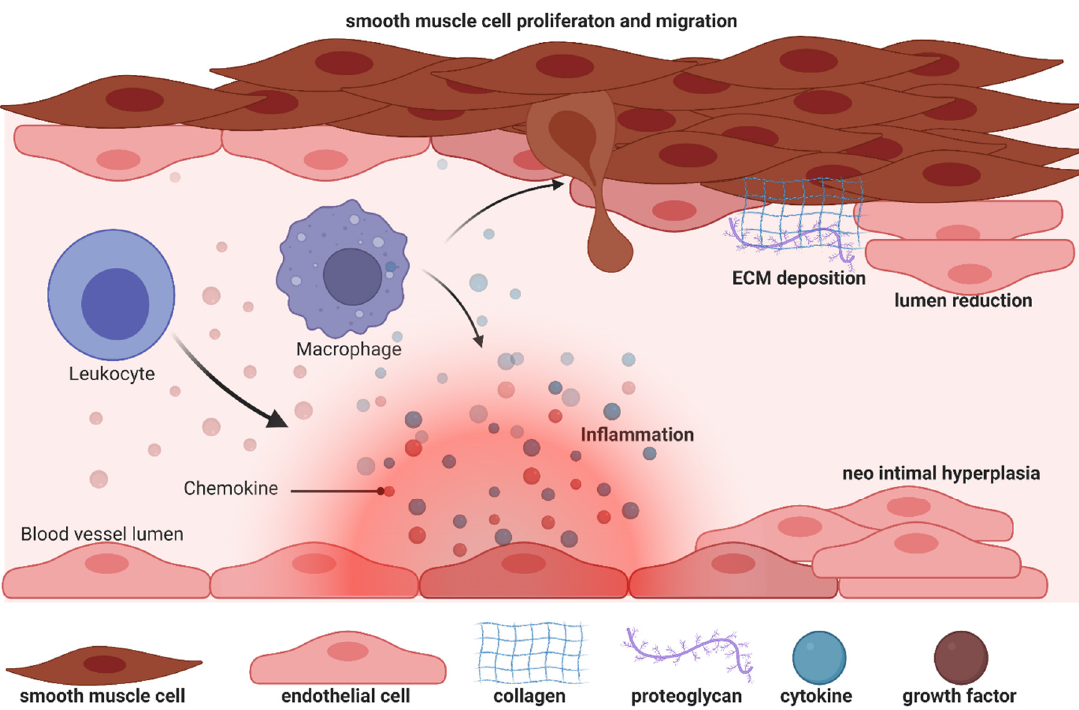
Figure 3. Biology of efferent vein wall of AVF remodelling.